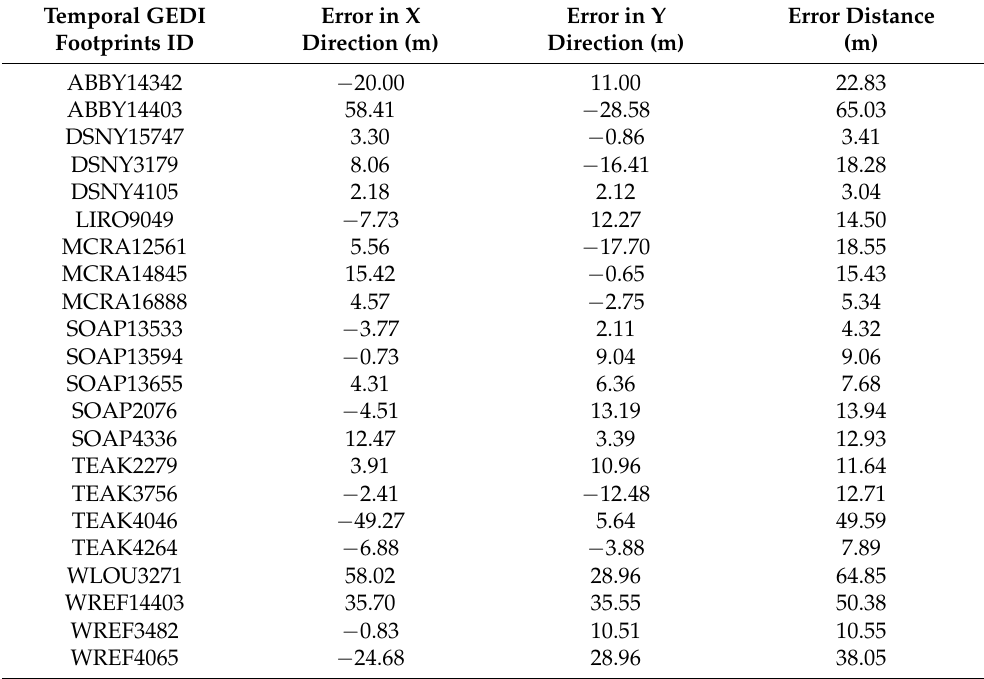
Table 3. The geolocation error distances of multi-temporal GEDI footprints.